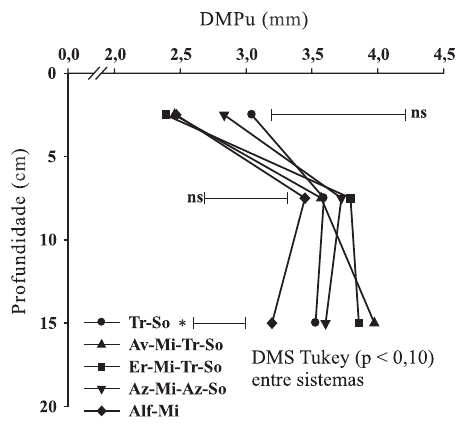
de agregados de um latossolo Vermelho sob sistemas de culturas em plantio direto, nas camadas de 0–5, 5–10 e 10–20 cm. tr-so: trigo- soja; av-Mi-tr-s o: aveia-milho-trigo-soja; er-Mi-tr-so: ervilhaca-milho-trigo-soja; az- Mi-az-so: azevém-milho-azevém-soja; alf-Mi: alfafa-milho. Barras horizontais representam a diferença mínima significativa pelo teste de tukey (p < 0,10) (ns: não significativo; *: significativo a 10 %).